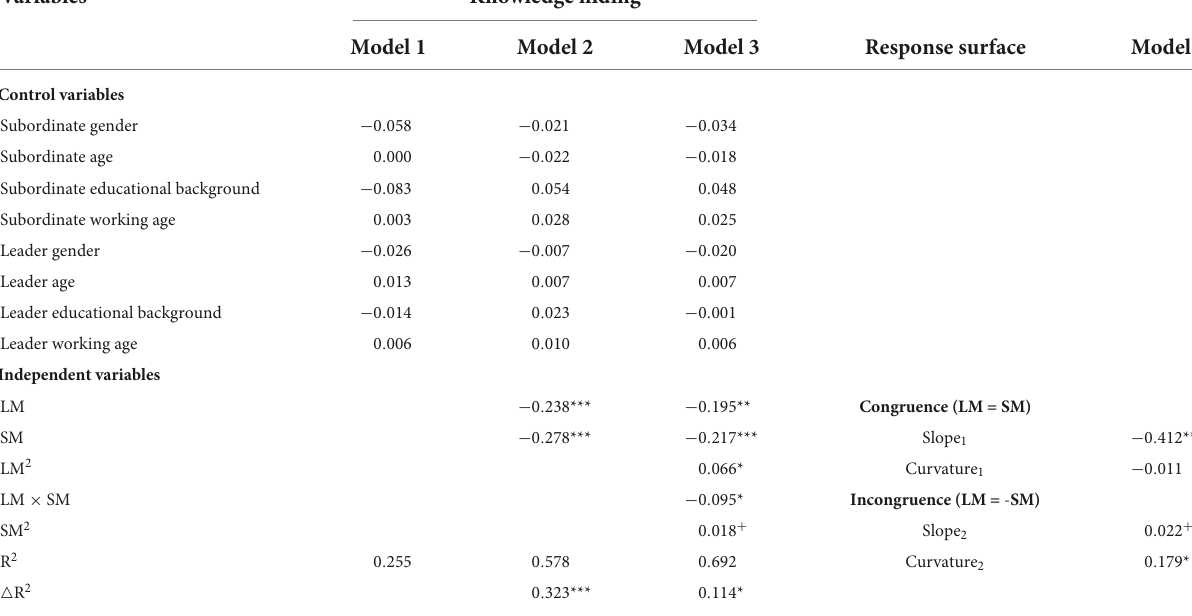
TABLE 3 Polynomial regression and response surface analysis.